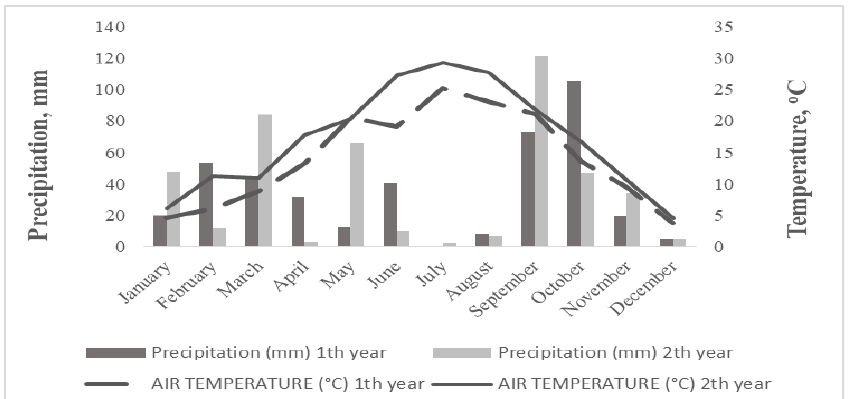
Figure 1. Average temperature (°C) and precipitation (mm) in the studied area during the 2015–2016 and 2016–2017 cultivation years.